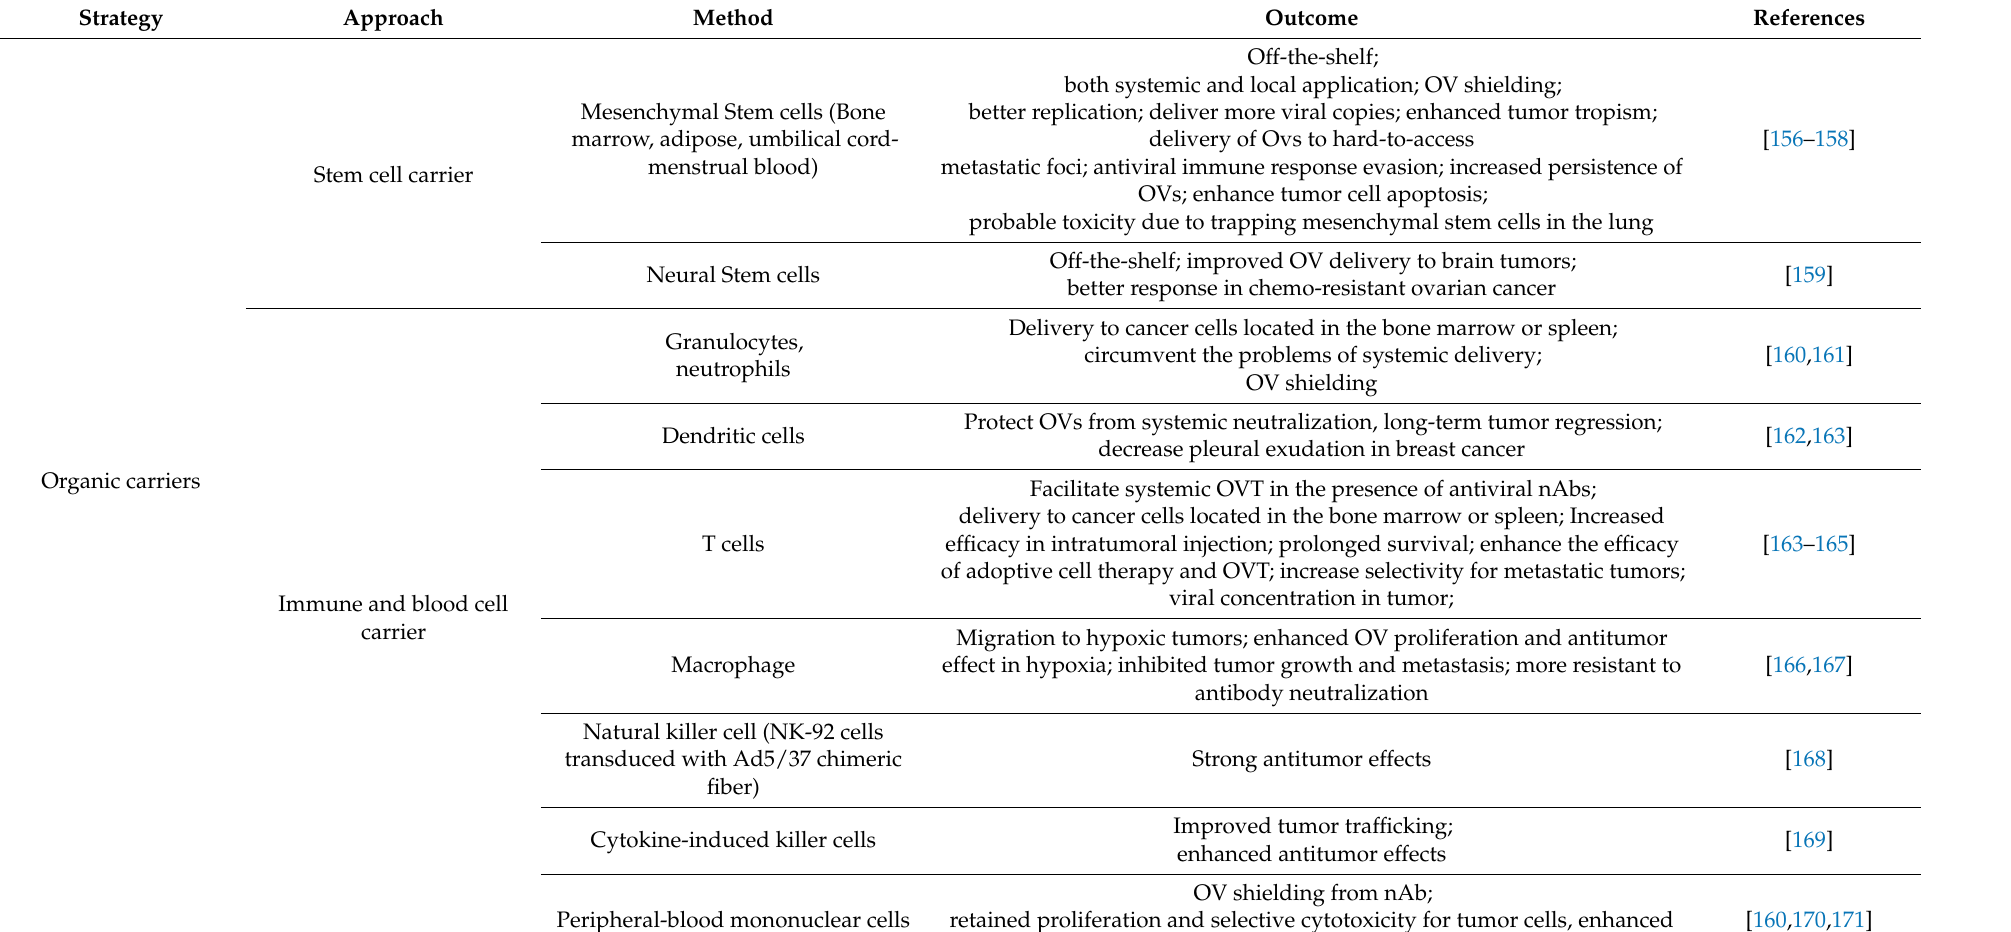
Table 2. Delivery approaches to enhance tumor access by oncolytic